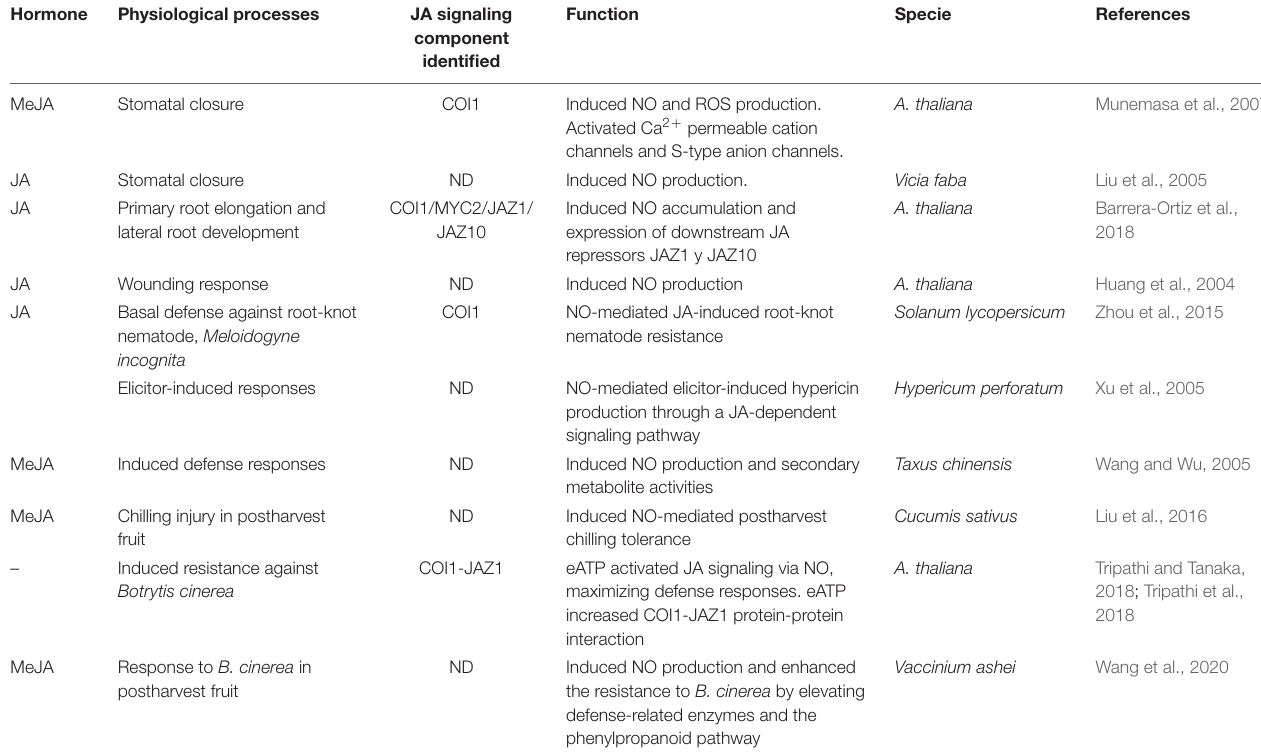
TABLE 2 | Crosstalk between JAs signaling and NO in diverse physiological processes. Hormone